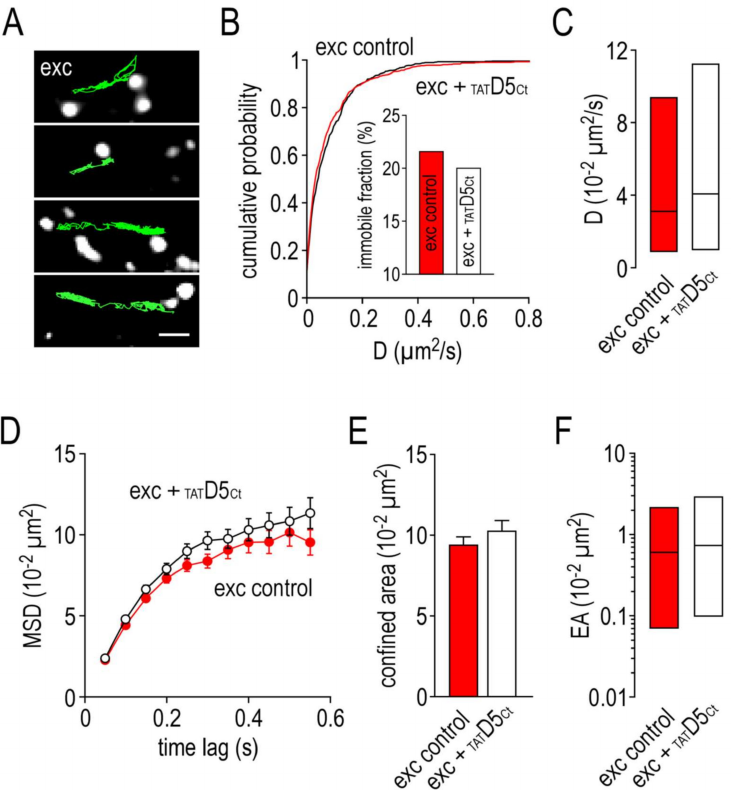
Figure 5. The disrupting peptide has no impact on the surface dynamic properties of GABA A receptors at excitatory synapses. ( A ) Examples of trajectories of a single GABA A receptor–SEP– anti-GFP antibody–QD complex (500 frames, 50 ms acquisition) in the presence of the competing peptide (10 µ M) with identified excitatory (exc) synaptic areas. Scale bar, 350 nm. ( B ) Cumulative probability diffusion coefficient of GABA A receptors at excitatory synapses in control condition or in the presence of the disrupting peptide. The inset shows the immobile fraction (defined as D < 0.005 µ m 2 /s) in the excitatory area in control condition and in the presence of the disrupting peptide. ( C ) Bar graphs illustrating the instantaneous diffusion coefficient (D, represented as median ± interquartile range 25–75%) in excitatory area in control condition or in the presence of the disrupt- ing peptide. ( D ) Comparison of GABA A receptors mean square displacements (MSD, represented as mean ± SEM) in excitatory area in control condition or in the presence of the disrupting peptide. ( E ) Bar graphs illustrating the confined area (for the time period of 250–550 ms and represented as mean ± SEM) in excitatory area in control condition or in the presence of the disrupting peptide. ( F ) Bar graphs illustrating the explored surface area (EA, represented as median ± interquartile range 25–75%) in excitatory area in control condition or in the presence of the disrupting